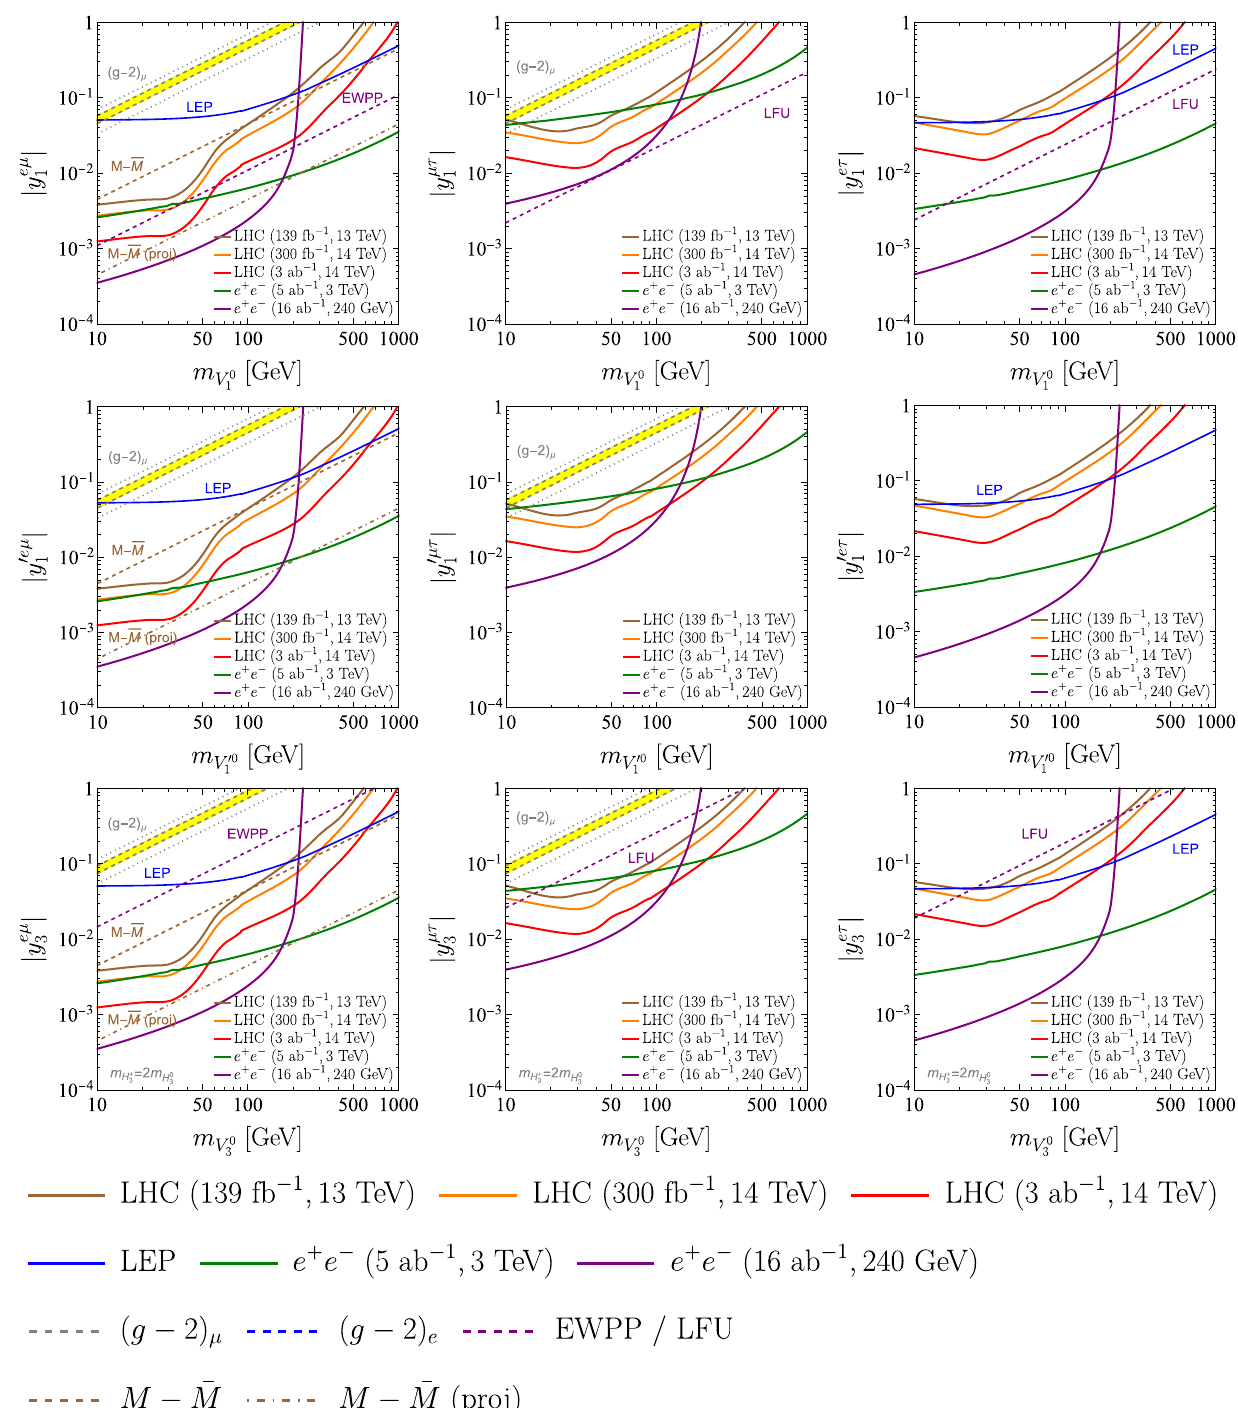
Fig. 2 Projected sensitivity of the colliders to the couplings y e μ (left column), y μτ (middle column) and y e τ (right column) for V 1 (top row), V (cid:7) (middle row) and V 3 (bottom row). The 1 σ and 3 σ muon AMM 1 favored regions are in the yellow band and dotted band, respectively. = 2 m For V 3 weassume m toevaluatethemuonAMMconstraint. V 0 3 V + 3